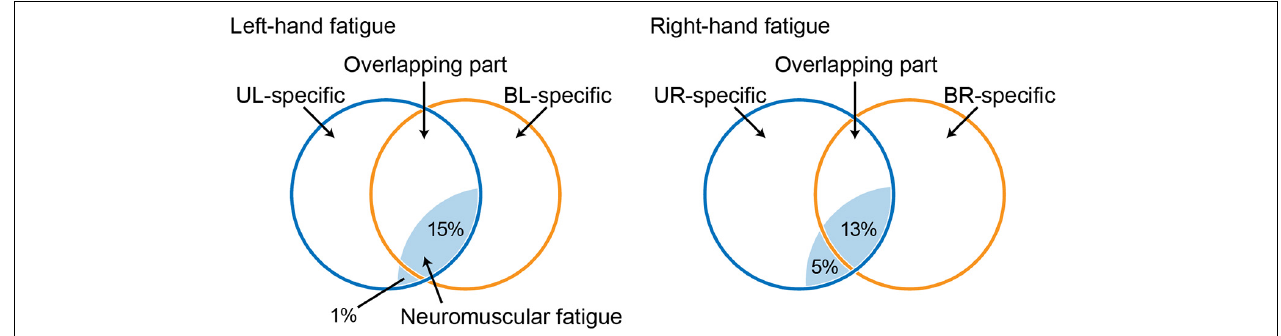
FIGURE 4 | Venn diagram showing the relationship between a force-generating system and unimanual neuromuscular fatigue, based on a previous study (Nozaki et al., 2006; Hayashi and Nozaki, 2016). Circles indicate unimanual-specific (blue) or bimanual-specific (orange) force-generating parts, and the common area of two circles indicates an overlapping force-generating part. Light blue shaded areas indicate neuromuscular fatigue caused by the fatigue task. UL, unimanual left; BL, bimanual left; UR, unimanual right; BR bimanual